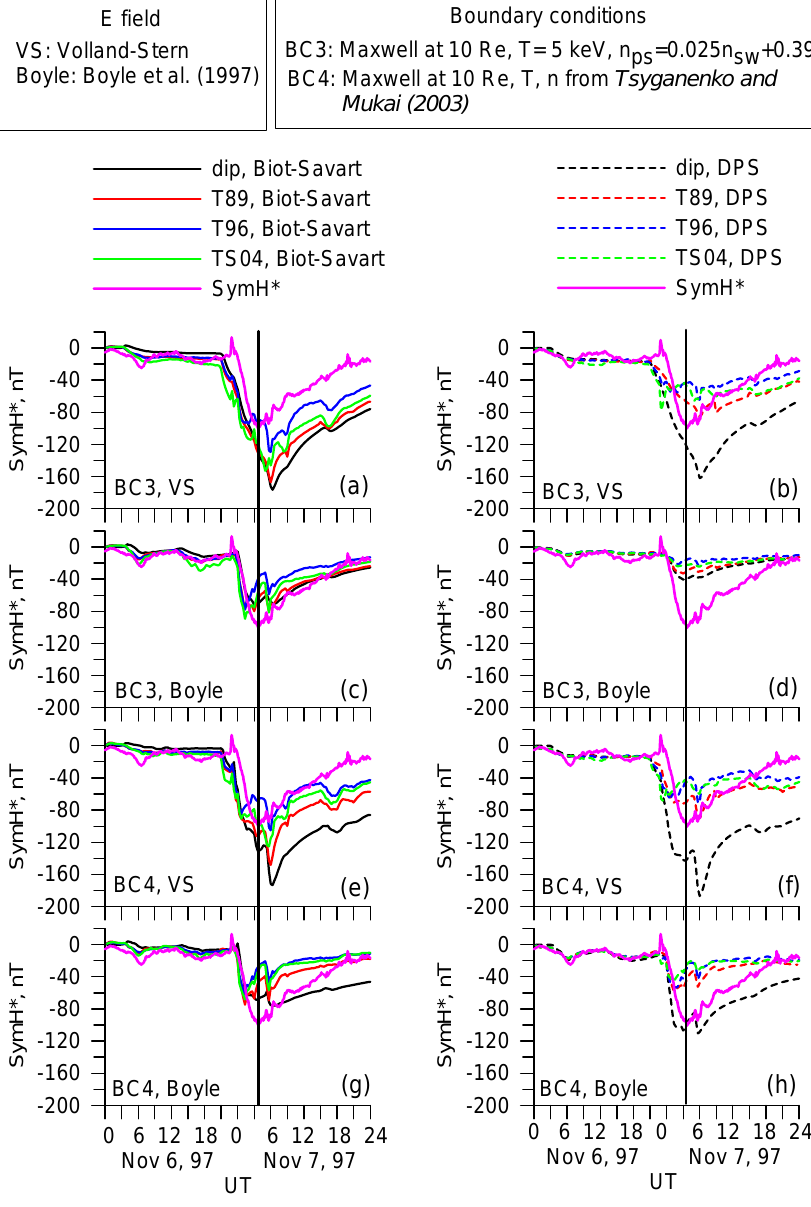
Fig. 9. Similar to Fig. 8 but for boundary distribution at 10 R E